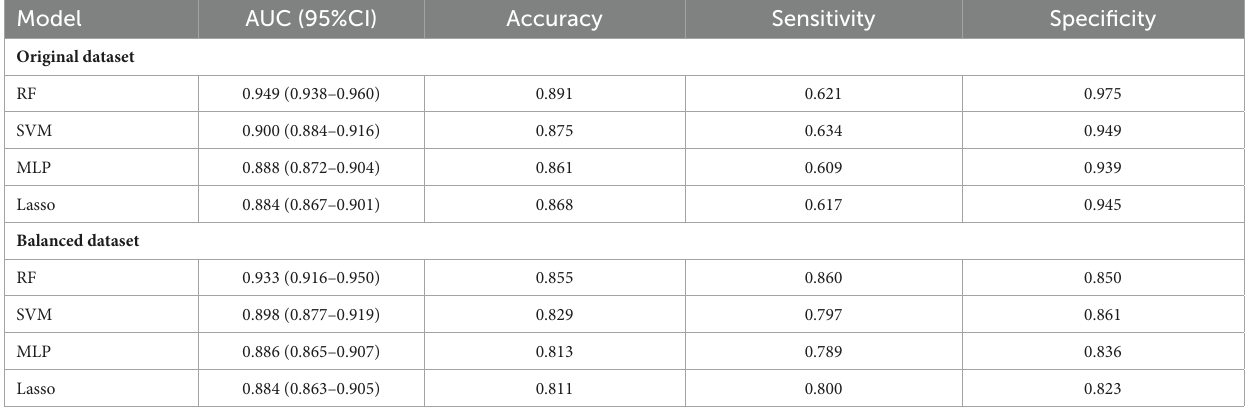
TABLE 5 The AUC of each model in training sets of original dataset and balanced dataset by 10 times 4-fold cross